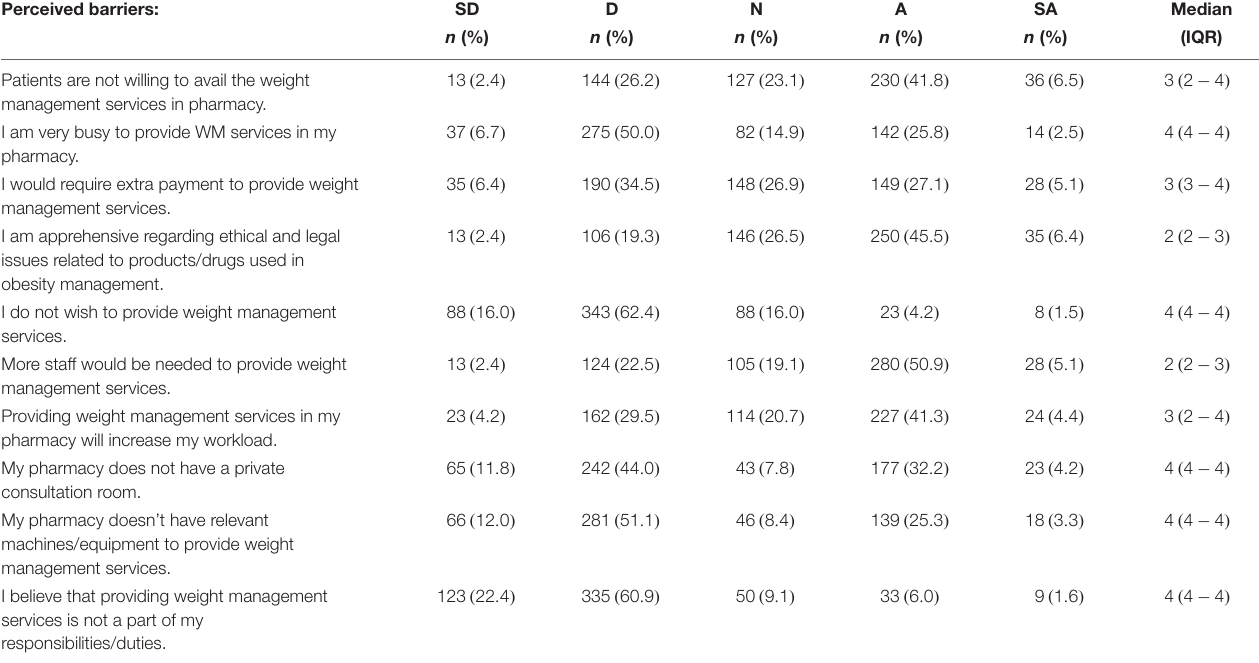
TABLE 4 | Barriers to the provision of WMS in community pharmacies. Perceived